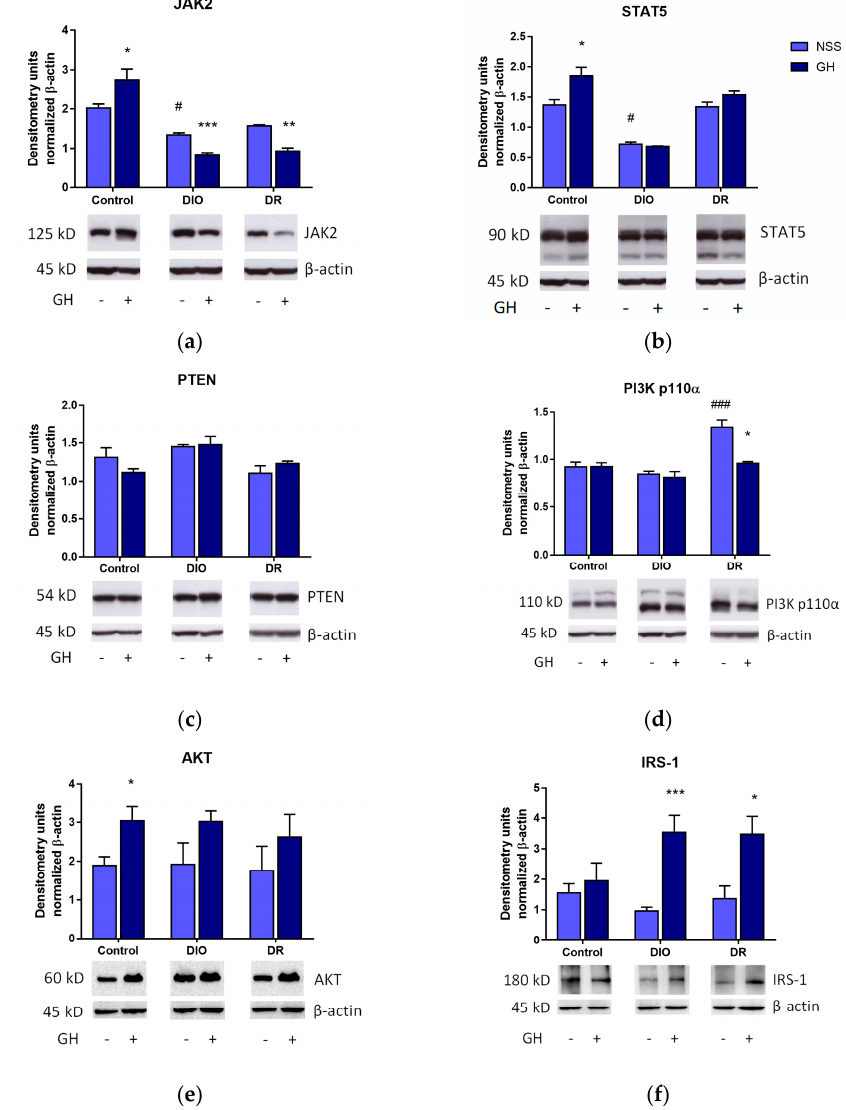
Figure 6. ( a ) Liver JAK2 protein levels; *, **, *** represent statistical significance differences between GH and NSS groups ( p < 0.05, p < 0.01, p < 0.001, respectively), # represents statistical significance differences with the control group ( p < 0.05). ( b ) Liver STAT5 protein levels; * represents statistical significance differences between GH and NSS groups ( p < 0.05), # represents statistical significance differences with the control group ( p < 0.05). ( c ) Liver PTEN protein levels. d ) Liver PI3K p110 α protein levels; * represents statistical significance differences between GH and NSS groups ( p < 0.05), ### represents statistical significance differences with the control group ( p < 0.001). e) Liver AKT protein levels; * represents statistical significance differences between GH and NSS groups ( p < 0.05). f) Liver IRS-1 protein levels; *, *** represent statistical significance differences between GH and NSS groups ( p < 0.05, p < 0.001, respectively). All results are presented as mean ± SEM; n = 6 per experi- mental group (NSS/GH of control and DIO rats), n = 5 per experimental group (NSS/GH of DR rats). These results indicated that impaired GHR signaling pathways were found in HC- fed rats, especially in DIO rats. A decrease of the GHR effector molecule, JAK2, was demonstrated after short-term GH administration in DIO rats. For insulin receptor signal- ing molecules, increasing IRS-1 was reported in HC-fed rats, both DIO and DR rats. The